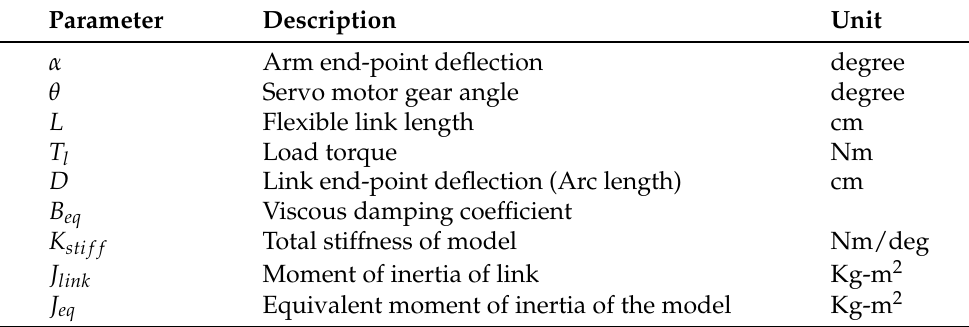
Table 3. Nomenclature used for